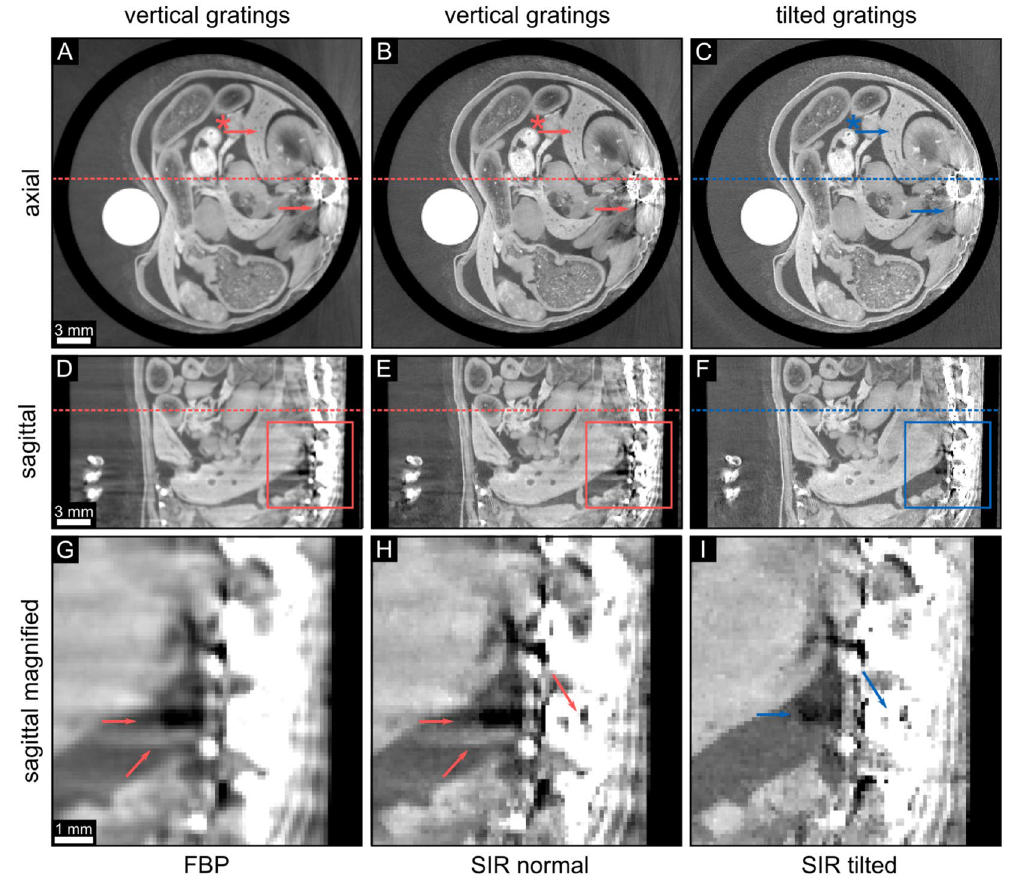
Figure 4. Comparison of non-tilted and tilted phase-contrast tomograms. Different reconstructed slices of the same mouse sample as shown in Fig. 3 are depicted. The left figure part was measured with vertical gratings, the right part was achieved with tilted gratings. The left column shows the FBP reconstruction of the data gained with vertical gratings in axial ( A ) and sagittal slices ( D ) and ( G ). The middle column visualizes the same data set reconstructed with the conventional SIR algorithm. The right column depicts the tilted SIR data set measured with tilted gratings. A magnification of the colored rectangles in the sagittal slices in subfigures ( D – F ) is visualized in the bottom row. There, the arrows mark particular differences in the corresponding sagittal slices. The arrows with asterisk mark an area which is highly affected by streaks in the non-tilted configuration (cf. Fig. 4). The dashed lines indicate the corresponding axial or sagittal slice. All phase-contrast values Φ are ranged in a linear scale of [ − 0.01,